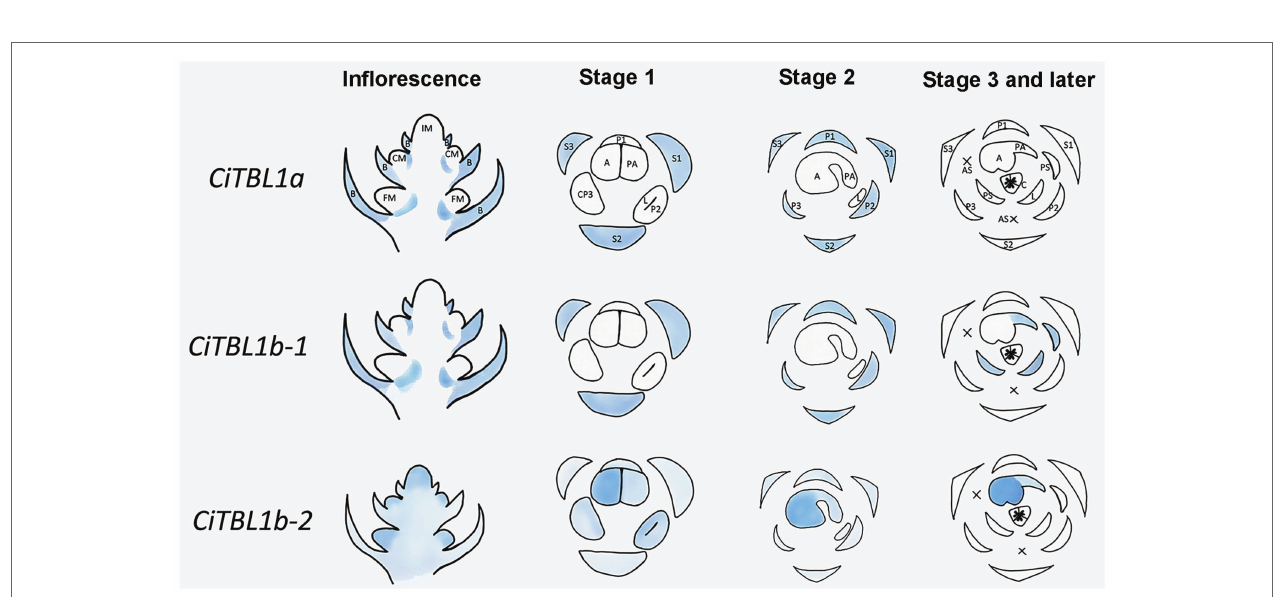
FIGURE 4 | The results of qRT-PCR showing the expression patterns of CiTBL genes in the late floral developmental stages. Relative expression of CiTBL1a , CiTBL1b-1 , and CiTBL1b-2 in (A) flower bud of three different lengths and (B) seven different organs. Data were normalized by the relative expression of CiTBL1a in 1.0-cm-long flower bud in (A) and petal in (B) . Error bars of gene expression are ±1 SD from three biological